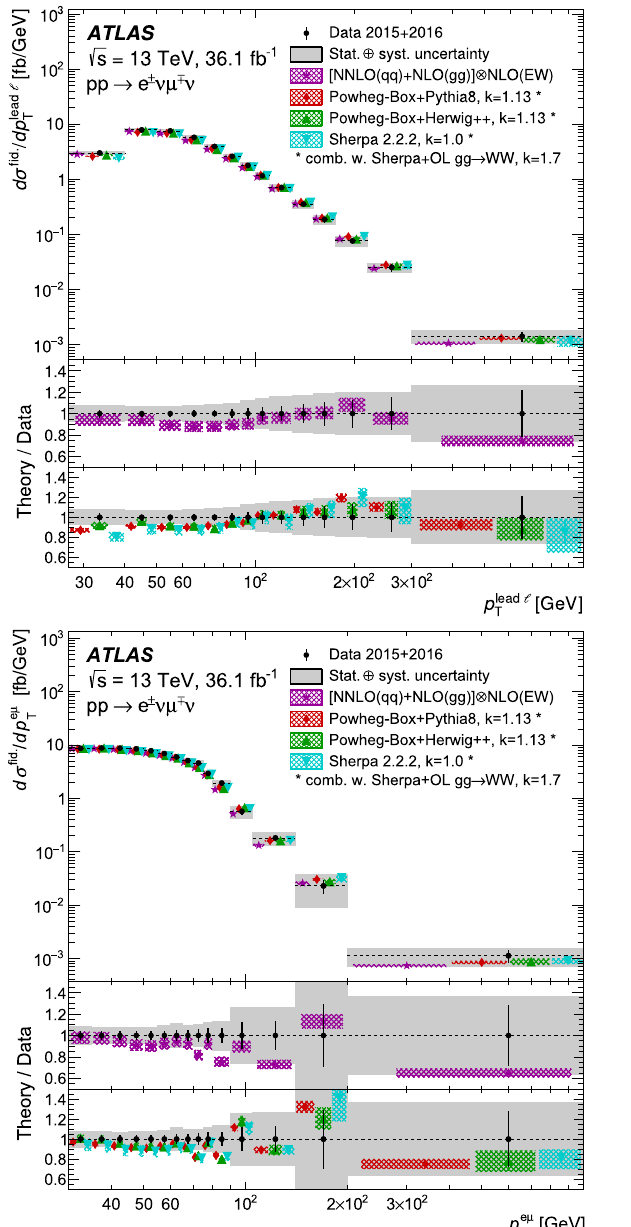
Fig. 7 Measured fiducial cross-sections of WW → e μ production for four of the six observables (from left to right and top to bottom): p lead (cid:5) μ m e μ , p e , and | y e μ | . The measured cross-section values are shown as T points with error bars giving the statistical uncertainty and solid bands indicating the size of the total uncertainty. The results are compared with the NNLO prediction with extra NLO EW corrections and NLO corrections for gg → WW production, and with NLO+PS predic-